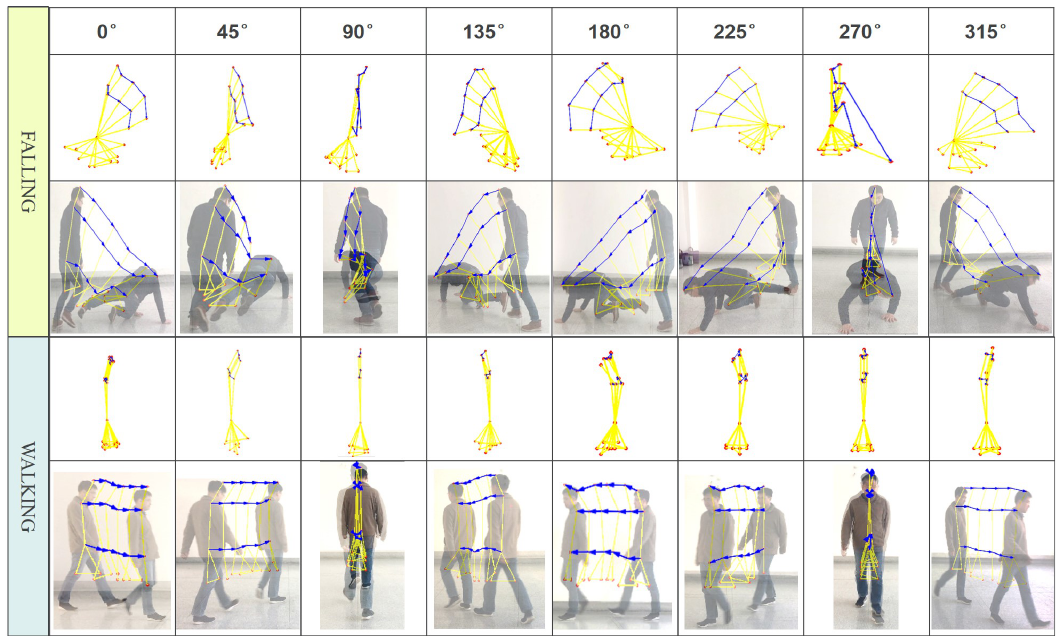
Figure 5. The standard spatio-temporal evolution maps for eight directional falling and walking samples.